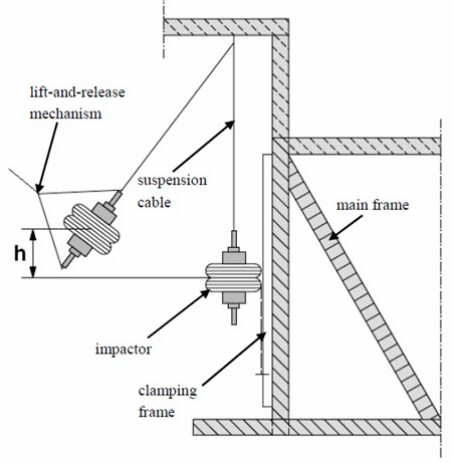
Fig. 1 Concept drawing of the pendulum impact test setup (EN 12600, 2002).